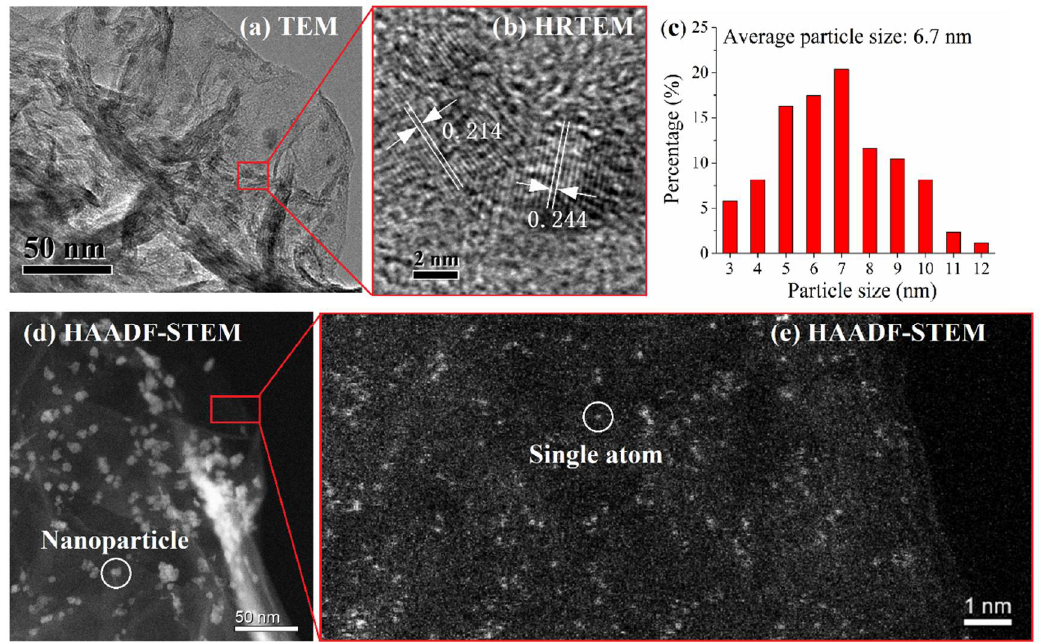
Figure 1. Characteristic results of Co 2.5 /rGO including ( a ) TEM image, ( b ) HRTEM image, ( c ) particle size distribution, and ( d , e ) HAADF-STEM